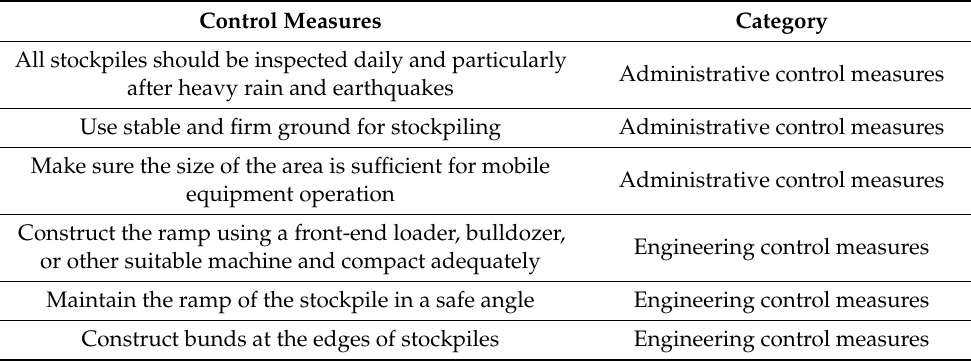
Table 7. The result of Query 3, in a tabular form.